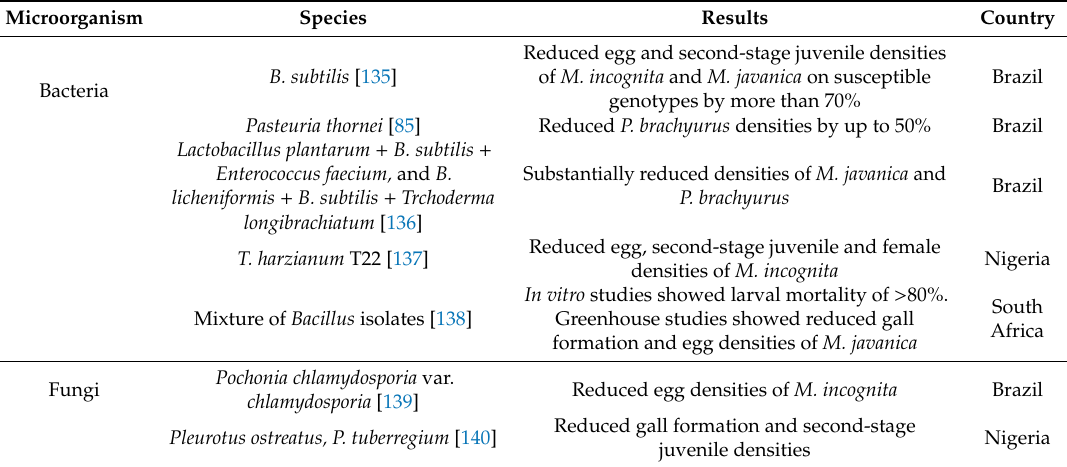
Table 3. Bacteria and fungi used in biocontrol of Meloidogyne and Pratylenchus spp. on soybean. Microorganism Species Results